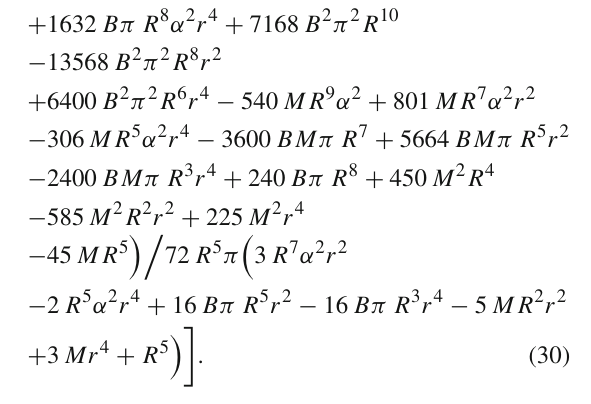
The variation of the anisotropic stress (Δ) with respect to the radial coordinate r / R is shown in Fig. 3. We find from